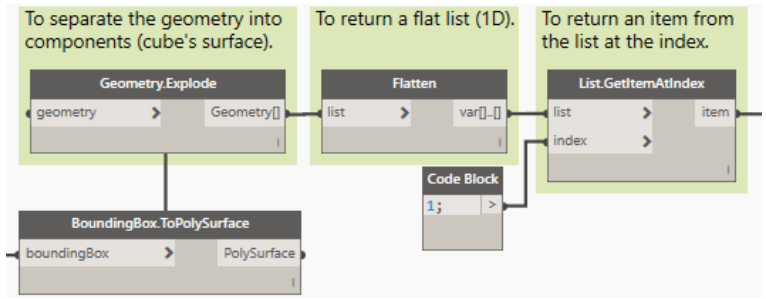
Figure A4. Obtaining surfaces of the construction element.